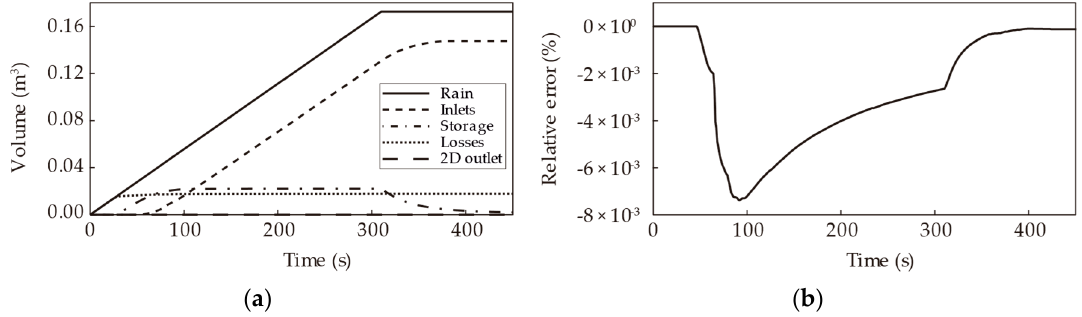
Figure 10. ( a ) Time series evolution of accumulative volumes; ( b ) mass balance error during the simulation for full-scale urban drainage physical model.